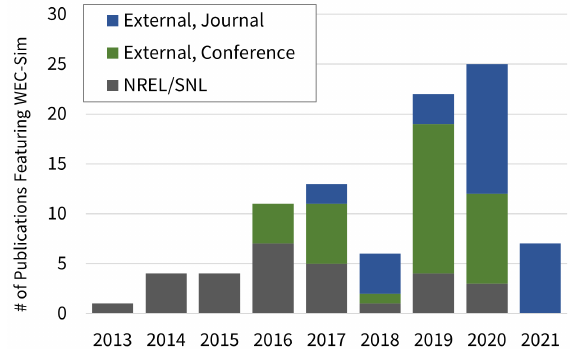
Fig. 2. Number of WEC-Sim publications found from January 2016 - March